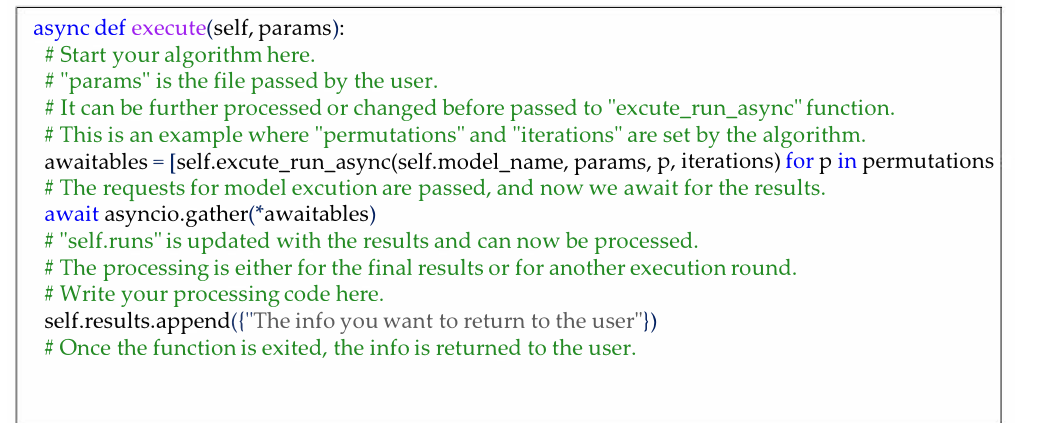
Figure A1. Code snippet for creating a new algorithm.